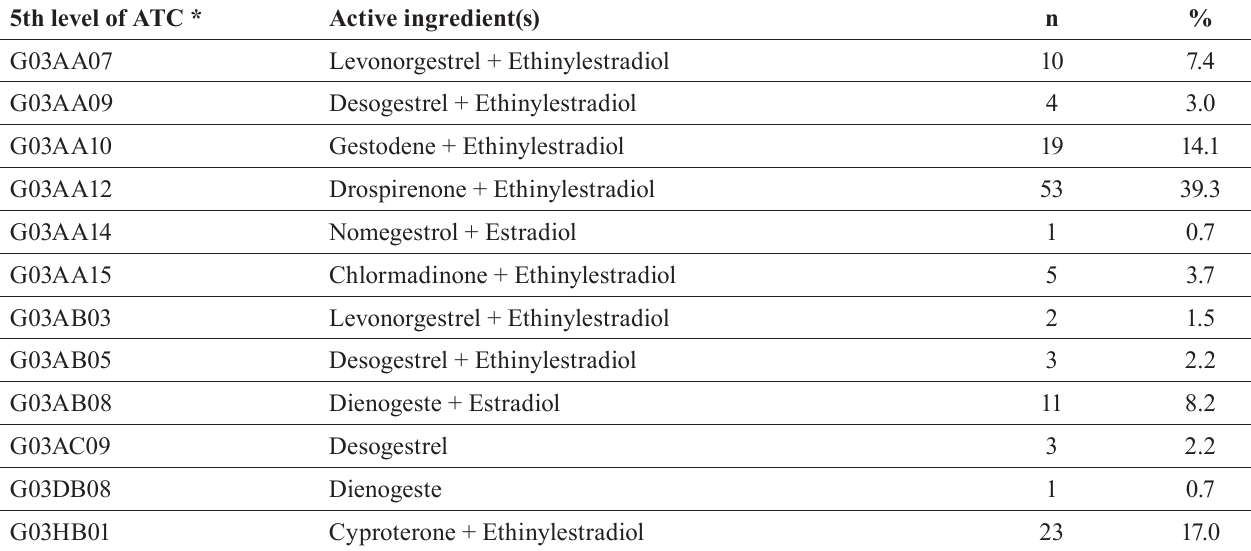
TABLE II - Use of oral hormonal contraceptives by pharmacy students according to the ATC classification (n =